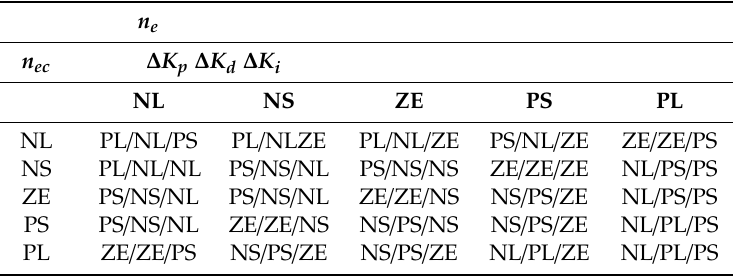
Table 1. Fuzzy rules of ∆ K p , ∆ K d , and ∆ K i .